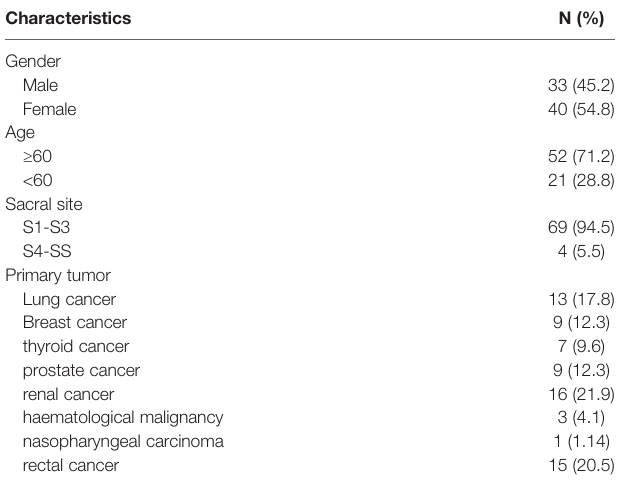
TABLE 1 | Patients information about the 73 sacral